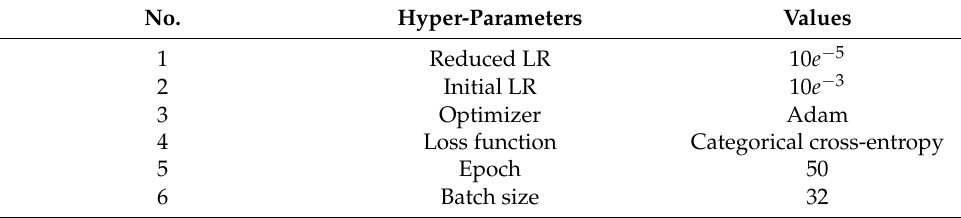
Table 3. Loss function and